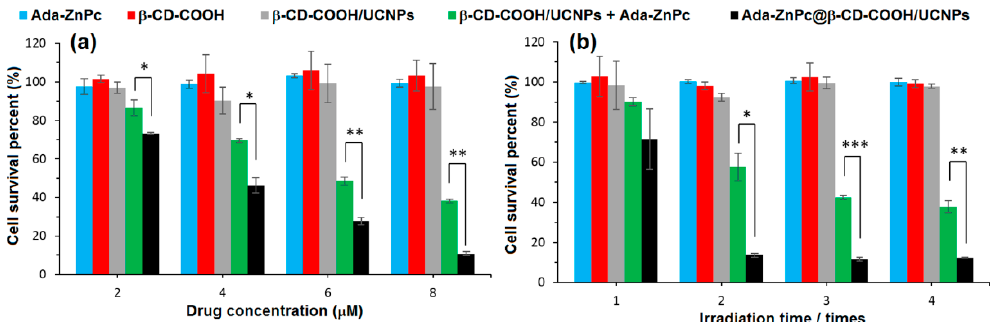
Figure 57. ( a ) Drug dose and ( b ) light dose-dependent in vitro PDT activity for β -CD-COOH/UCNPs, β -CD-COOH, Ada-ZnPc, β -CD-COOH/UCNPs + Ada-ZnPc, and Ada-ZnPc@ β -CD-COOH/UCNPs after 980-nm laser irradiation. * p < 0.05, ** p < 0.01, *** p < 0.0001. Adapted from Wang; Jin; Chen; Zhou; Zhou; Wei [192].